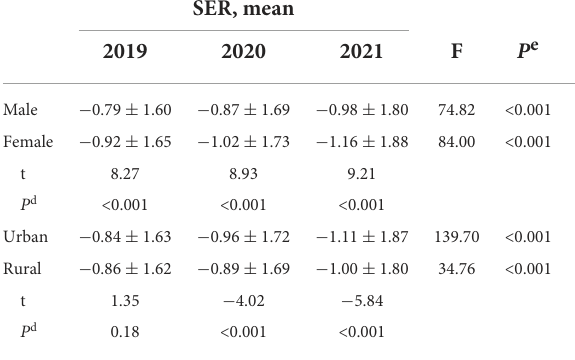
TABLE 4 SER values stratified by gender and region over 3